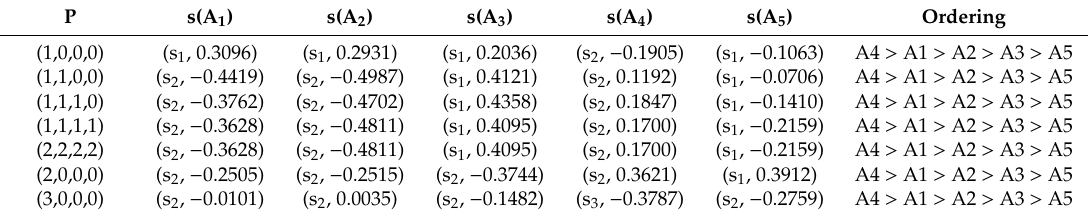
Table 5. Ranking results for di ff erent parameters of the SVN2TLWMM operator.